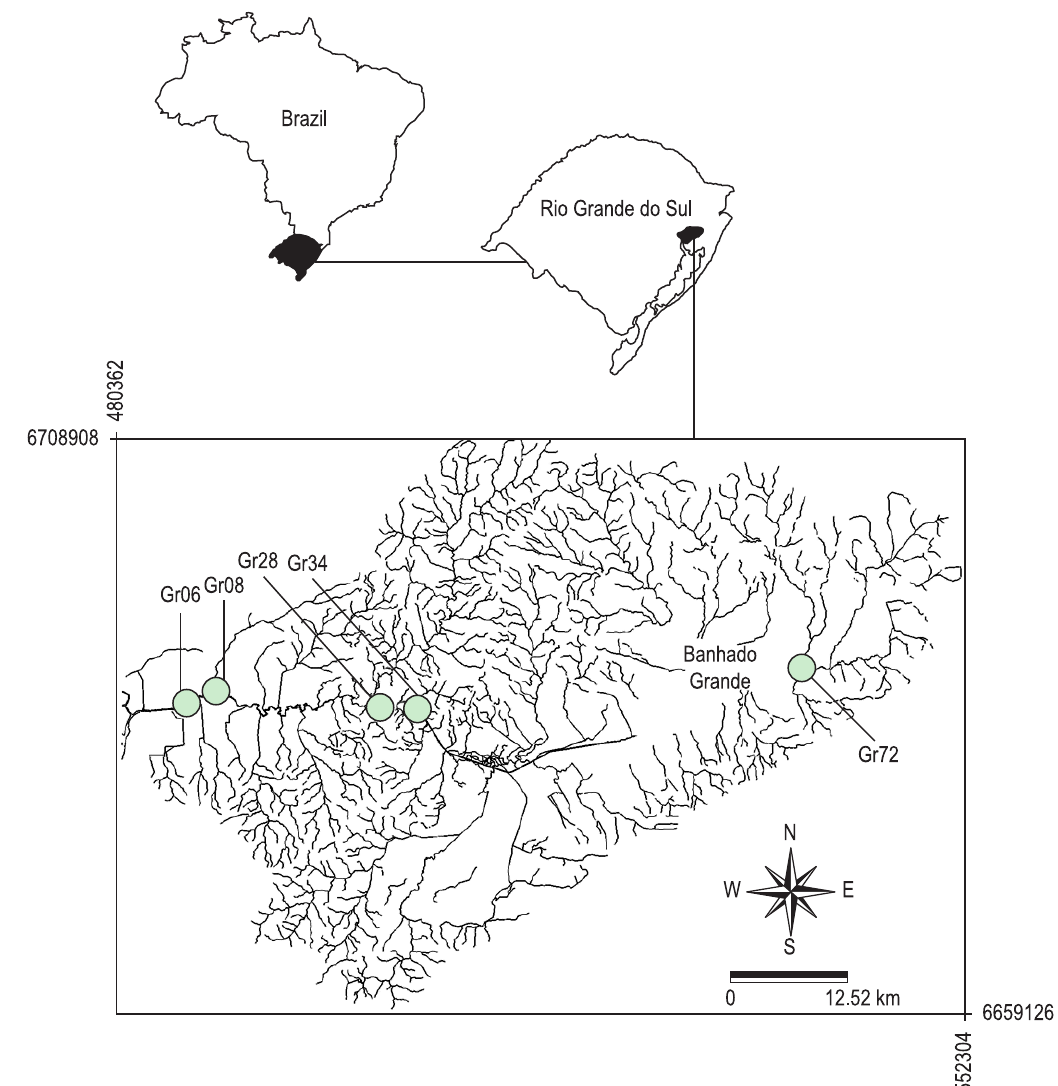
Figure 1. Sites Gr72, Gr34, Gr28, Gr08 and Gr06. Gravataí River Basin, Rio Grande do Sul State, Brazil. (Adapted map of Salomoni et al.